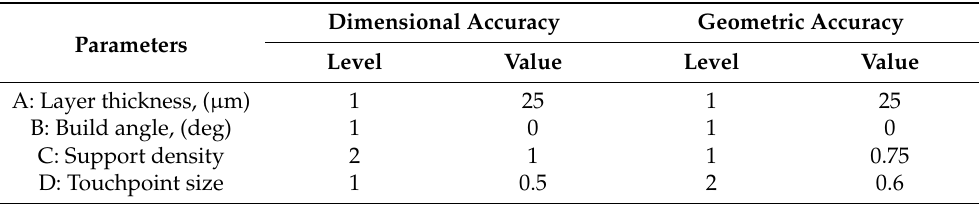
Table 15. Optimum values of parameters for dimensional accuracy and geometric characteristic of